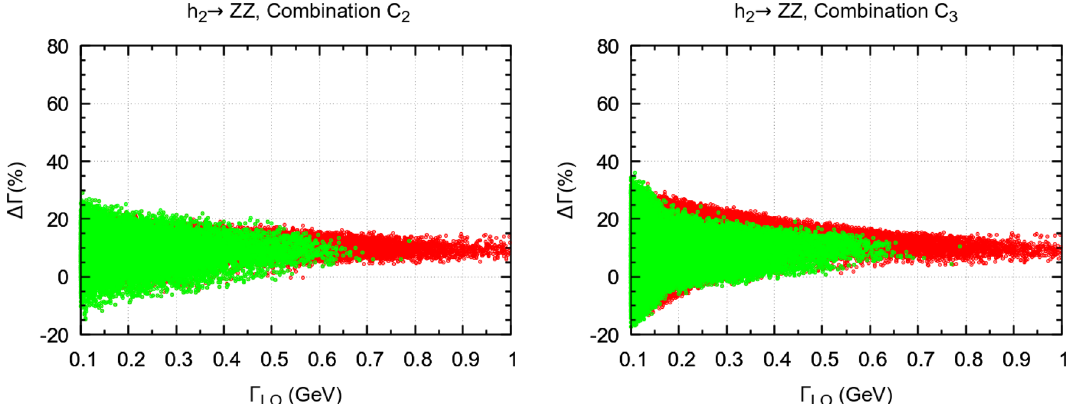
Figure 2 . ∆Γ h in percentage as a function of Γ LO 2 → ZZ (right). Only the interval 0 . 1 GeV < Γ LO < 1 GeV is shown. The color conventions are those of figure